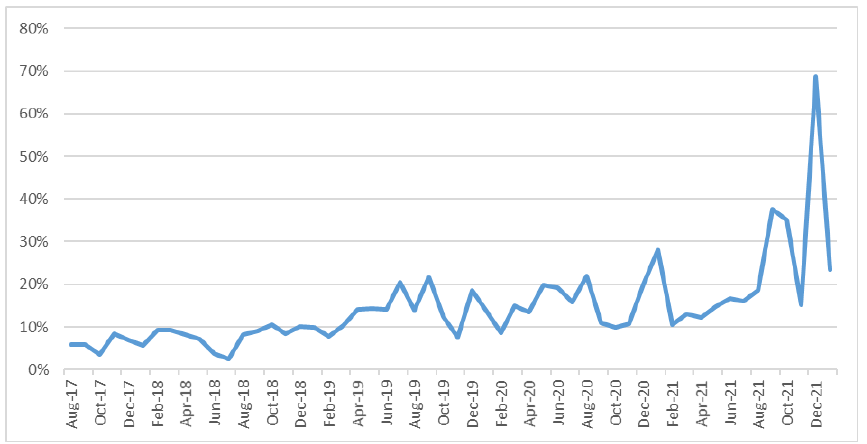
Figure 4. Relative difference of the best case and the worst case scenario for each